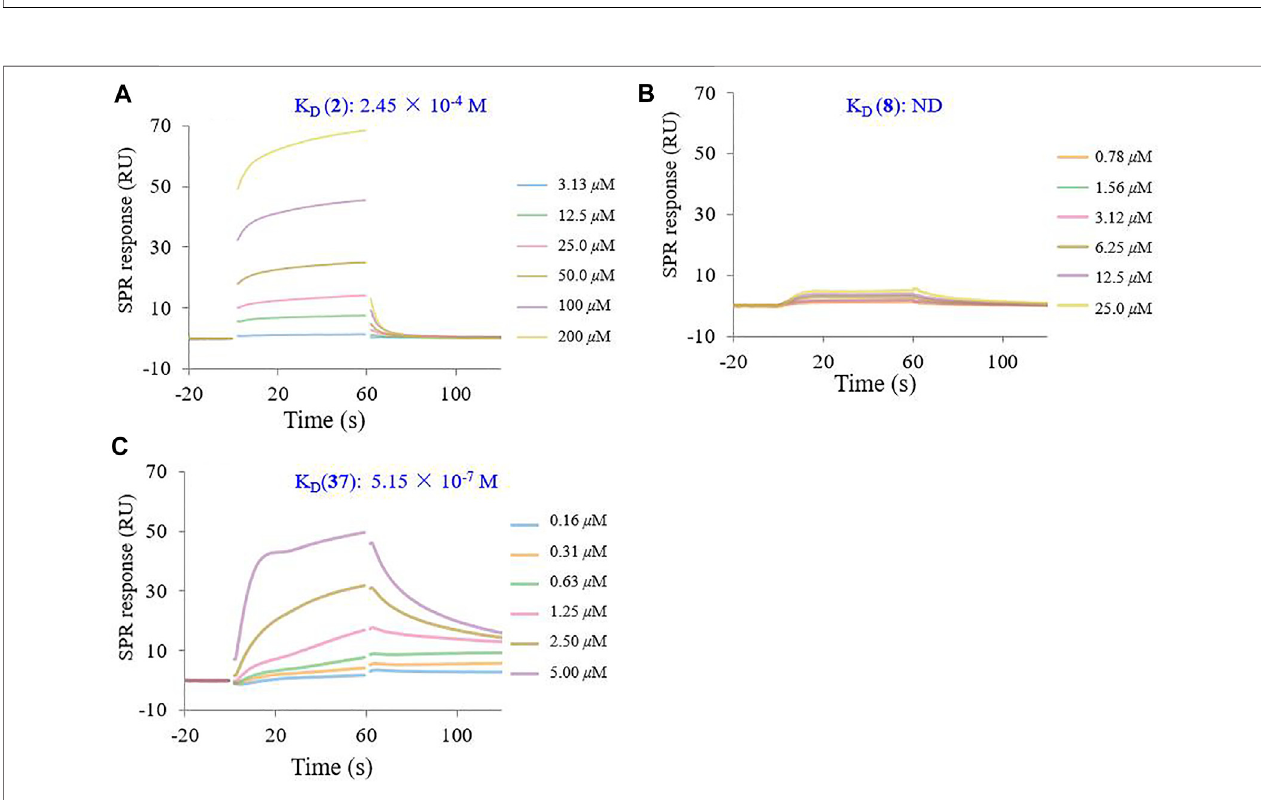
FIGURE6| SPRinhibition assay sensor grams showing response toin fl uenzaHAprotein inthe presence ofvaryingconcentrationsofGA ( 2 ) (A) , β -CD ( 8 ) (B) ,and their heptavalent conjugates 37 (C) . The binding kinetics was analyzed by the BIA evaluation 1.0.5 software with 1:1 (Langmuir) binding mode.